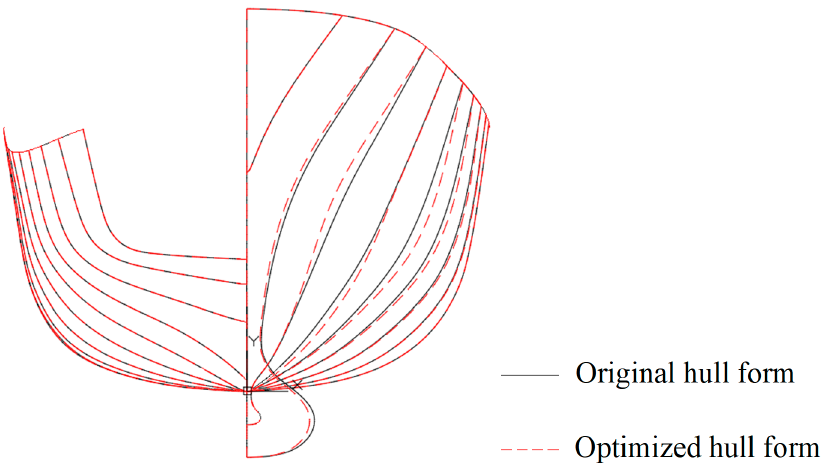
Figure 20. Optimization convergence curve of dimensionality reduction optimization.